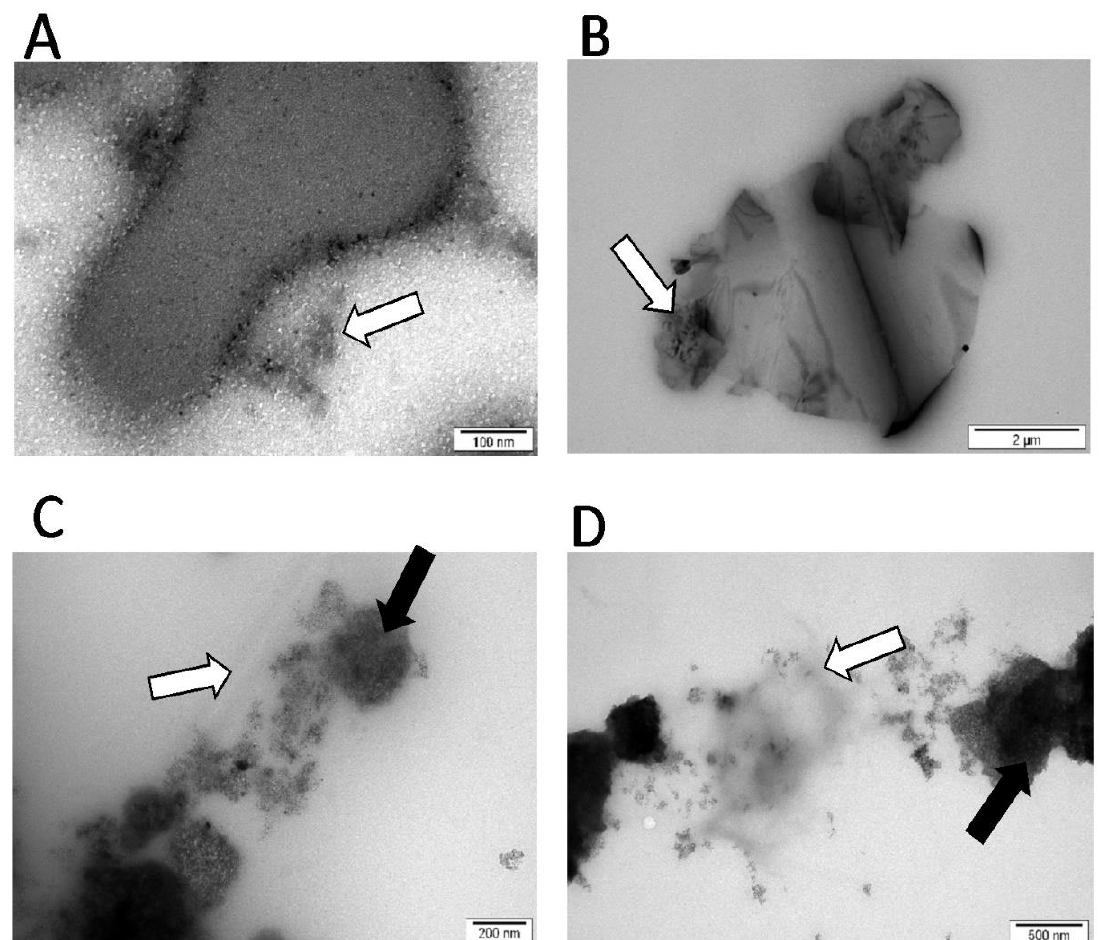
Figure 2. Complexes of melittin and nanoparticles (TEM). ( A ) Melittin (MEL); ( B ) MEL + graphene (GN); ( C ) MEL + nanographene oxide (nGO); ( D ) MEL + nanodiamond (ND). Carbonate nanoparticles = black arrows; MEL = white arrows.